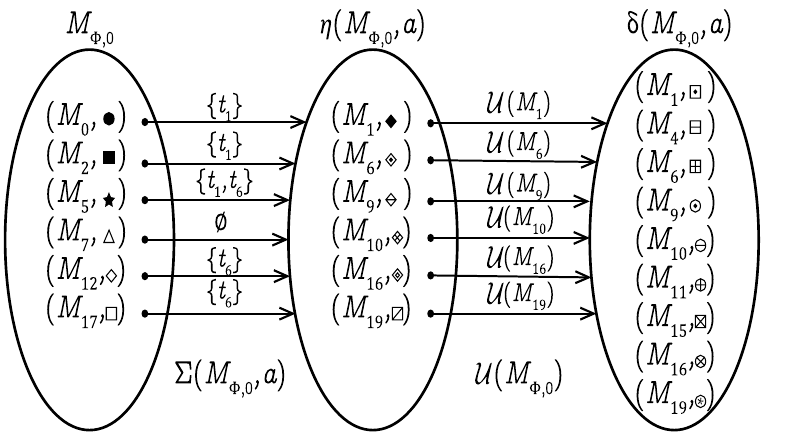
Figure 9. State transition from M (cid:31) ,0